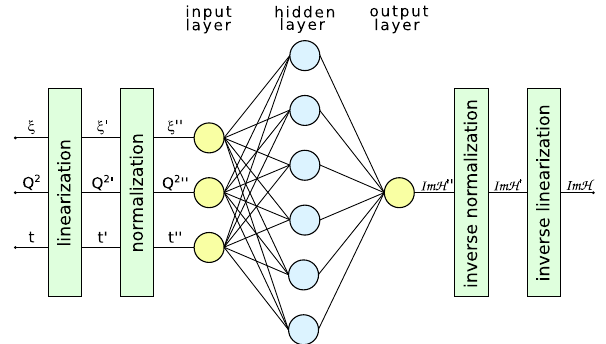
Fig. 6 Scheme of a single neural network that is used in this analysis to represent either the real or the imaginary part of a single CFF